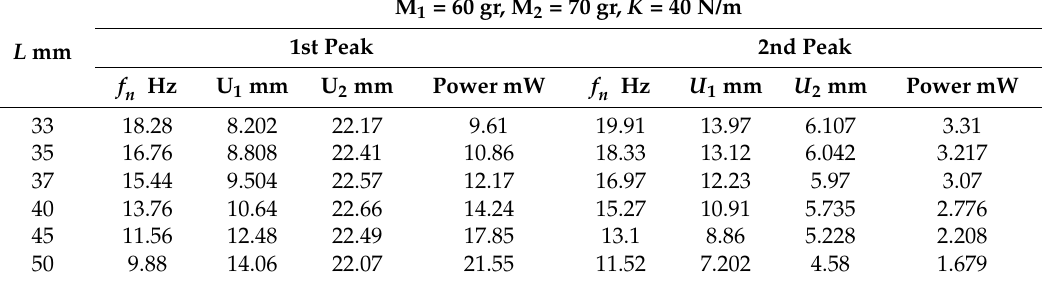
The influence of the bimorph length on the harvester amplitude—two bimorphs interconnected by a spring case.